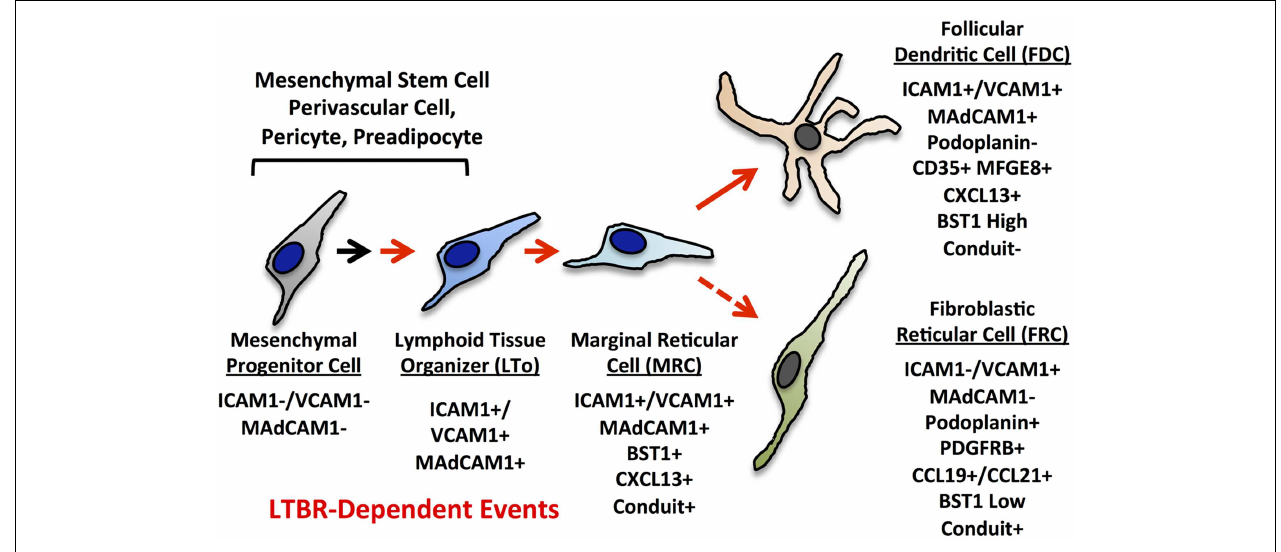
FIGURE 3 | Putative differentiation pathways for the FDC and FRC networks showing major phenotypic changes .The MRC is speculated to be a progenitor for FRC and FDC lineages based on phenotype, but this relationship has not been formally